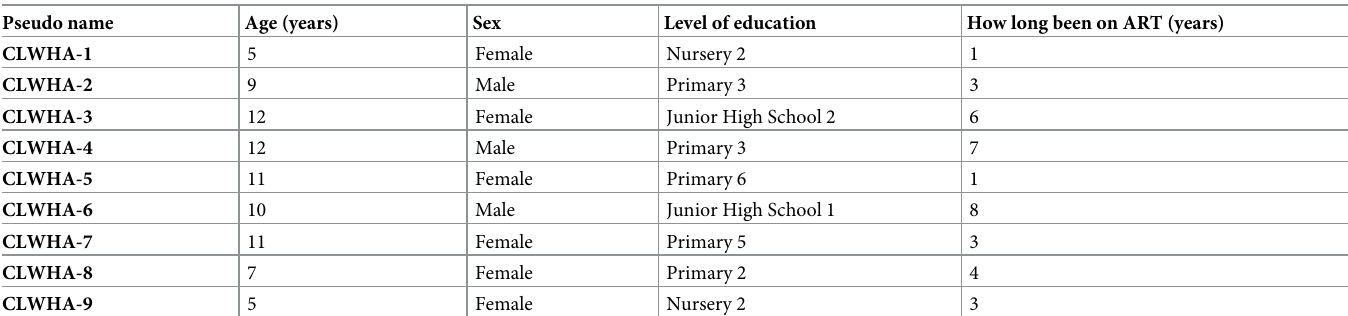
Table 2. Biographic data of children living with HIV/AIDS.